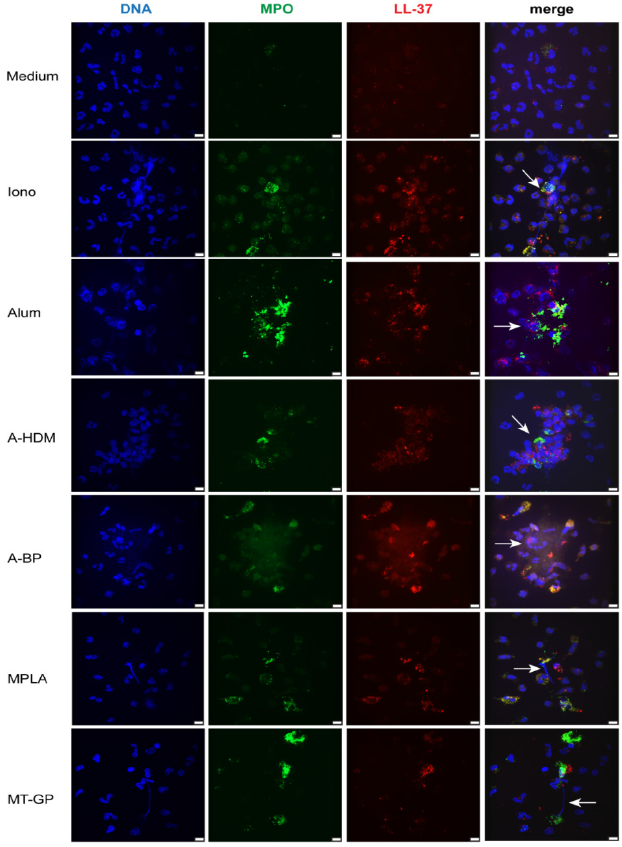
Figure 2. Induction of NETs by adjuvants and complete allergen-specific immunotherapy (AIT)- vaccines. Human neutrophils were primed with 25 ng/mL GM-CSF and incubated for 3 h with medium, ionomycin (Iono; 5 µ M), alum (100 µ g/mL), the alum-adjuvanted vaccines (100 µ g/mL), MPLA (5 µ g/mL) and MT-GP (2.25 µ g/mL). Co-localization of released DNA (blue) with the granular components MPO (green) and LL-37 (red) indicating NET formation is shown by confocal fluorescence microscopy. (Scale bars, 8 µ